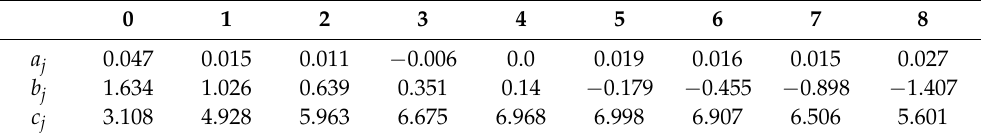
Table 2. Estimated Coefficients of the Left Fractal Curve. Table 3. Estimated Coefficients of the Right Fractal